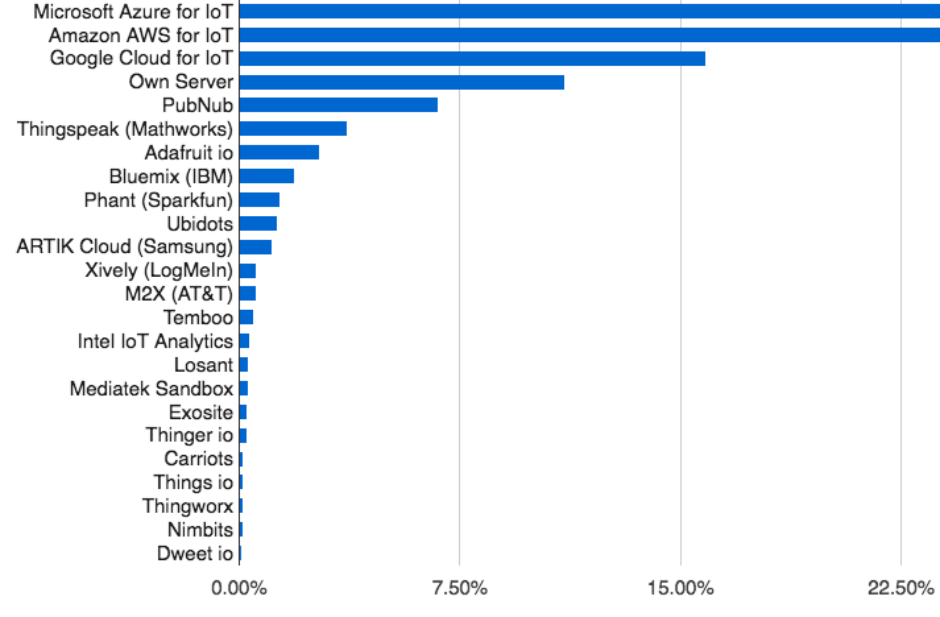
Figure 5. Top IoT platforms. Source: [41].